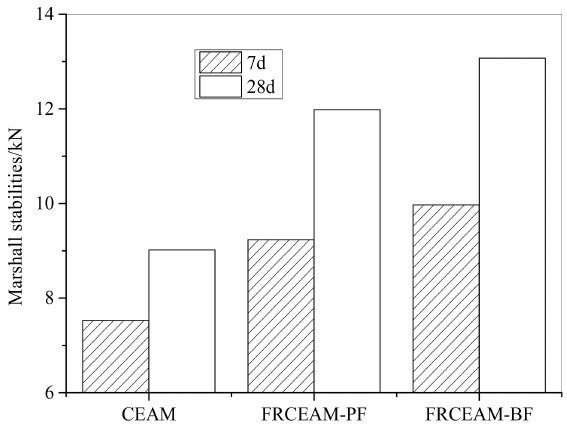
Figure 1. MS of CEAM and FRCEAM.